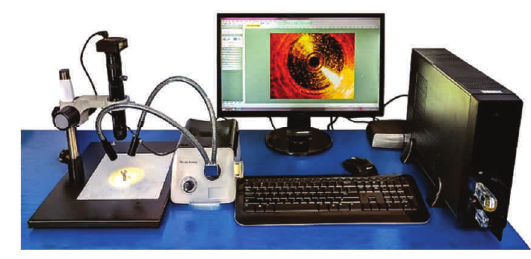
Fig. 5. Laboratory microscope FL150/70